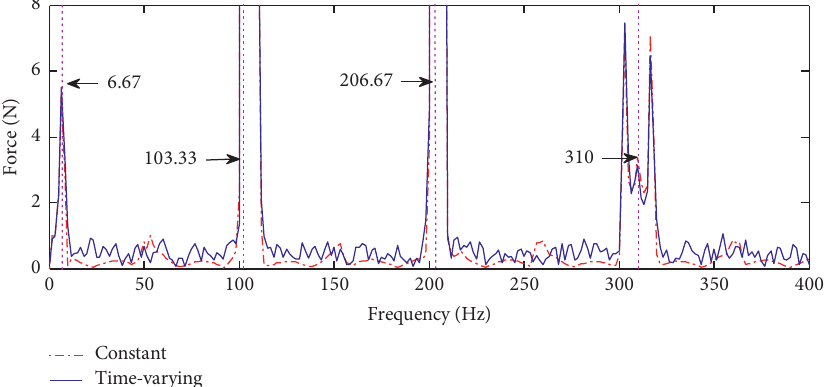
Figure 13: Meshing force spectrum of s- p